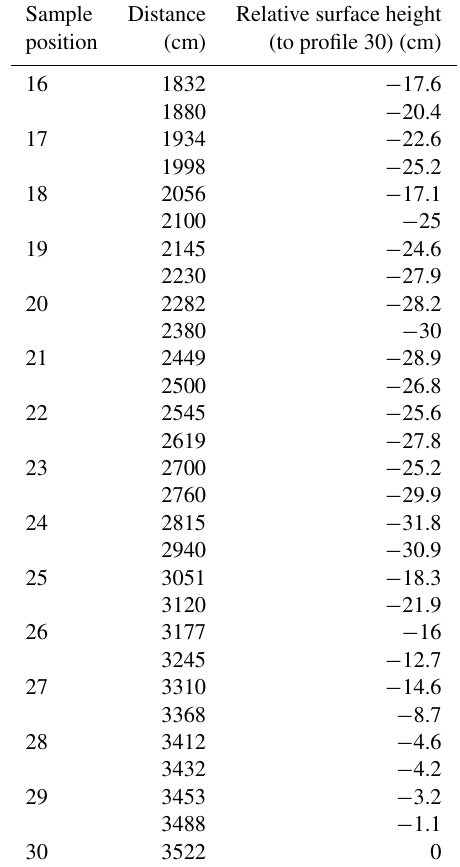
Table C1. Surface leveling along the OIR trench. Surface height was measured at and in between subsequent sampling positions. In column two we show the distance along the trench and in column three the relative surface height in relation to the last